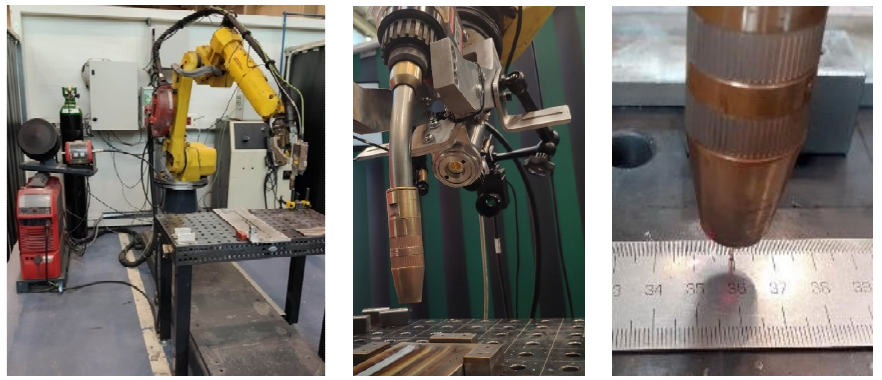
Figure 1. Manufacturing equipment.